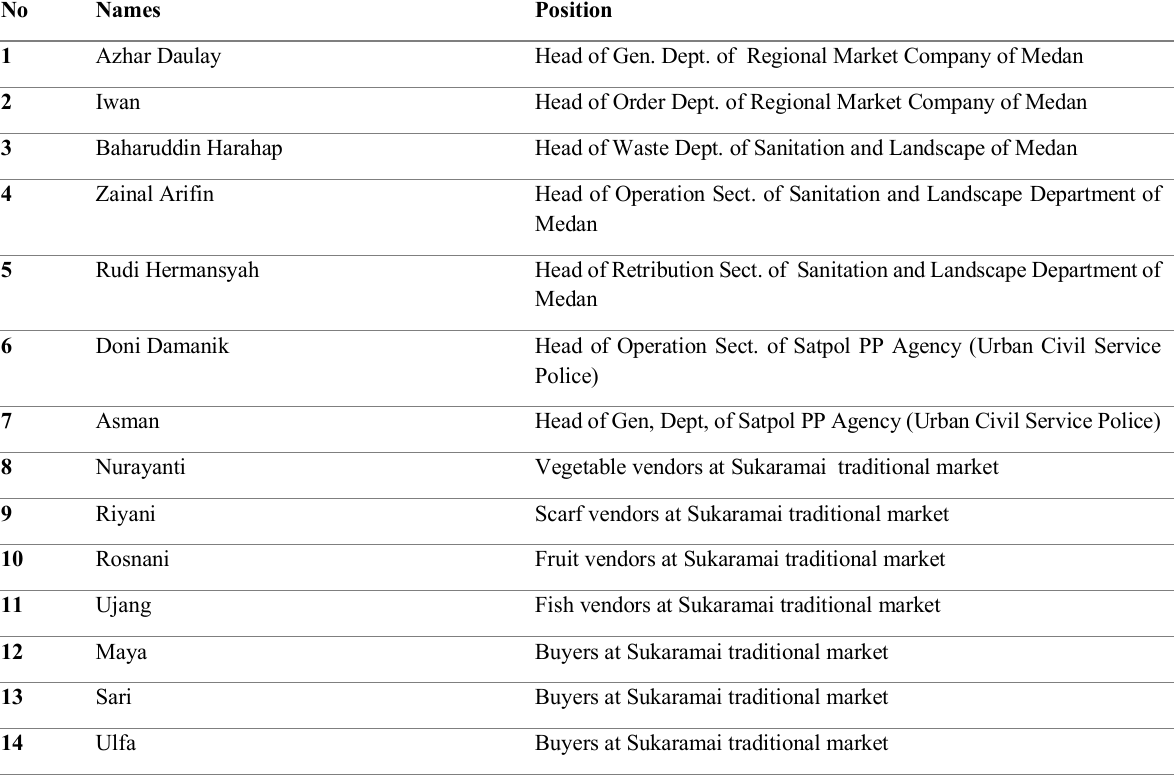
Table 1: List of